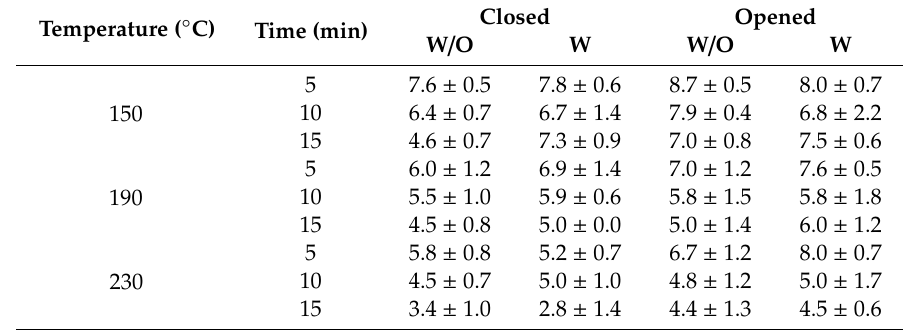
Table 6. Results of the subjective color